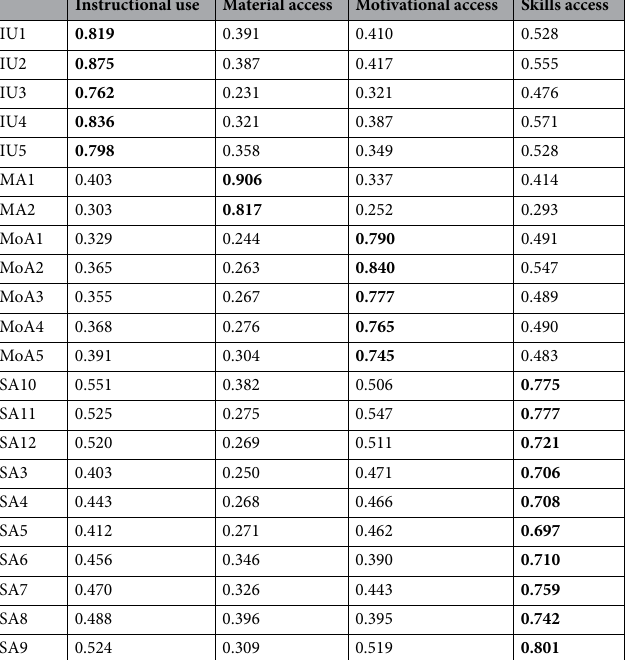
Table 3. Cross-loading. Significant values are in bold.